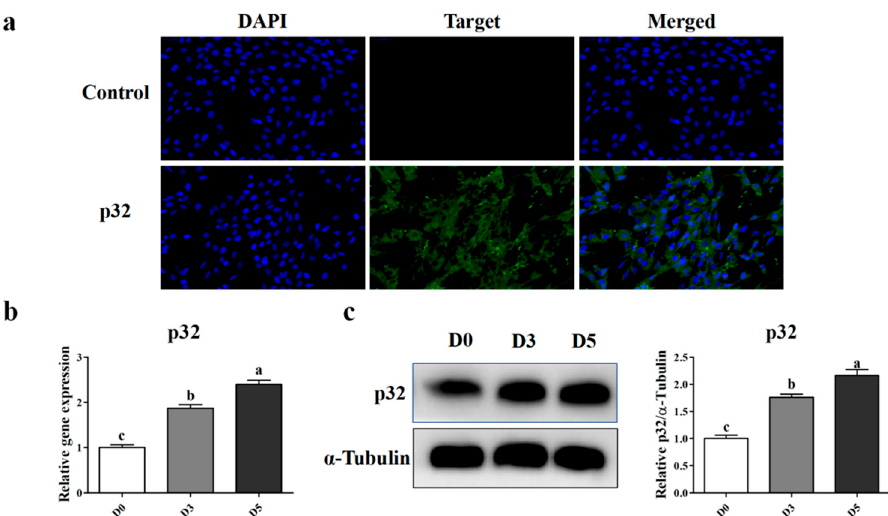
Figure 4. Immunofluorescence analysis of the p32 protein in sheep myoblasts ( a ). Sheep myoblast stain with the p32 antibody (green) and nuclear stain DAPI (blue). Scale bar = 100 μ m. The expression of the p32 mRNA ( b ) and protein ( c ) during myoblasts (and differentiated into myotubes) was detected by qRT-PCR and Western blot. The expression was normalized to glyceraldehyde-3- phosphate dehydrogenase ( GAPDH ) and related to the D0. Results are expressed relative to the D0 as mean values ± SEM ( n = 3). a, b, c: different letters denote statistically significant differences within each group; p < 0.05.